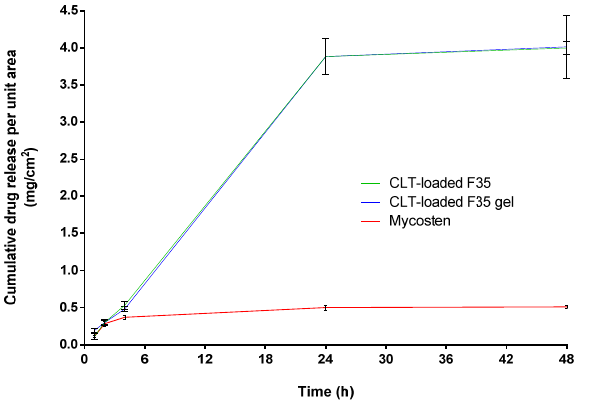
Figure 4. The releasing profile of CLT-loaded F35, CLT-loaded F35 gel, and CLT commercial product, Mycosten ® in Franz diffusion cells for 48 h. Each value represents the mean ± standard deviation from three independent experiments.